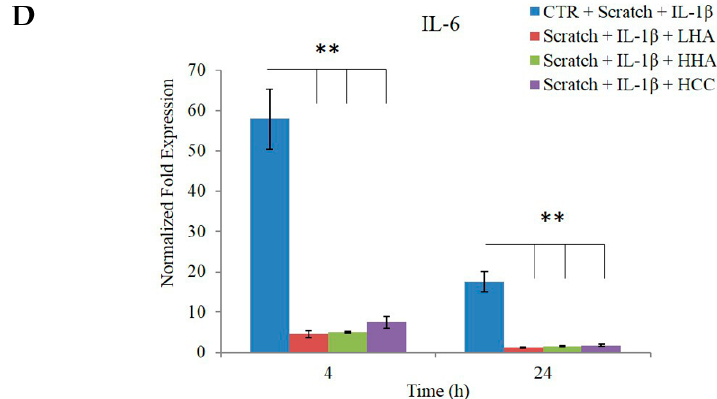
Figure 7. E ff ects of LHA, HHA, and HCC on mRNA expression in HaCaT / HDF co-cultures in comparison with a control sample. The HaCaT / HDF cells were scratched and stimulated with IL-1 β for 2 h in DMEM with 10% FBS, and then treated with HA and its complex. Data are presented as mean ± SD. At 4 and 24 h, the total RNA was extracted and qRT-PCR was performed to determine the gene expression of ( A ) MMP-2, ( B ) MMP-9, ( C ) TNF- α , and ( D ) IL-6. * p < 0.01 for LHA, HHA, and HCC vs. control (CTR) at 4 h or LHA and HCC vs. CTR at 24 h; ** p < 0.05 for HHA vs. CTR at 24 h.